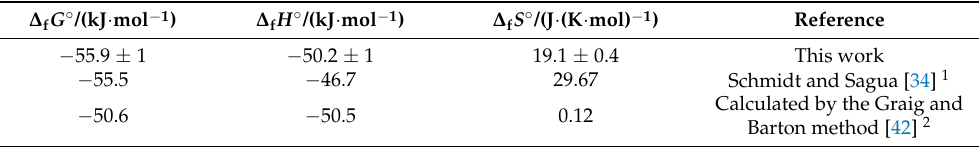
Table 3. A comparative summary of thermodynamic properties of Ag 1.2 Cu 0.8 S at 298 K and 1